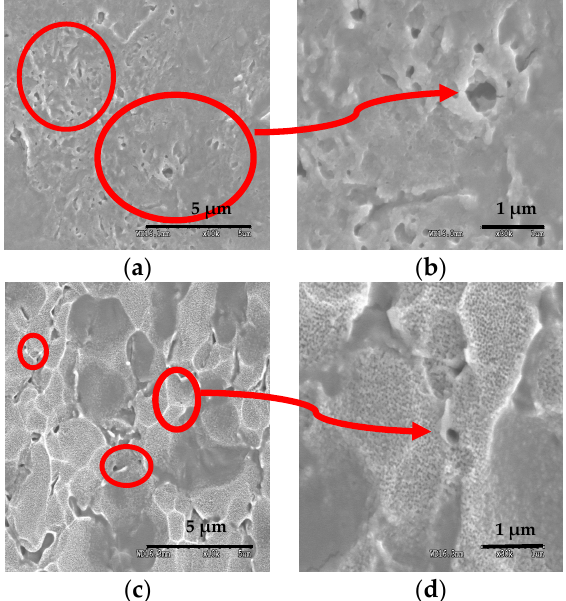
Figure 16. Low- and high-magnification FESEM images of ( a , b ) substrate and ( c , d ) anodized TiO 2 nanotube after the corrosion test.